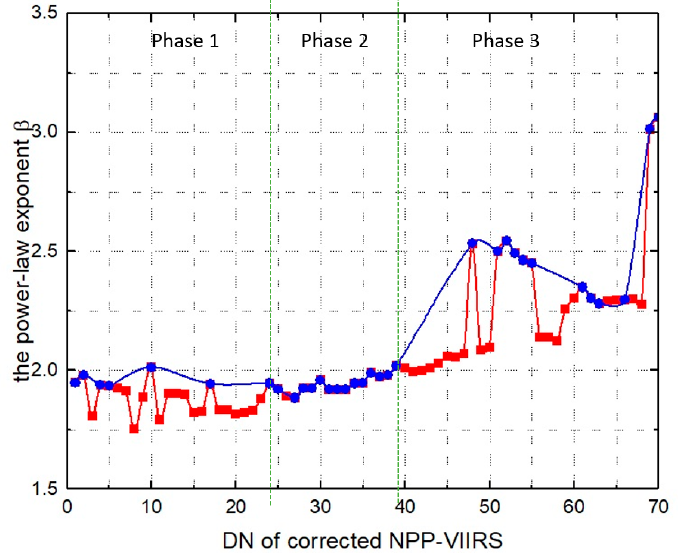
Figure 3. The transition of the power-law distribution exponent β on continuous thresholds. The blue line with circle symbols and the red line with square symbols, respectively, show the curve of the β on continuous thresholds with and without a p -value limit.